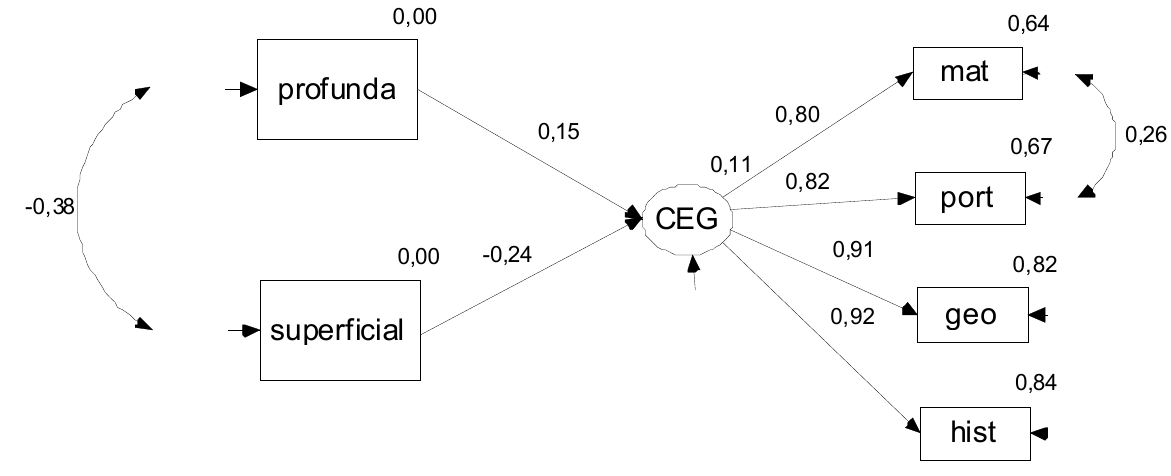
Figura 2 . Modelo Explicativo da Path Analysis – Cargas Fatoriais, Correlações e Variância Explicada da Amostra